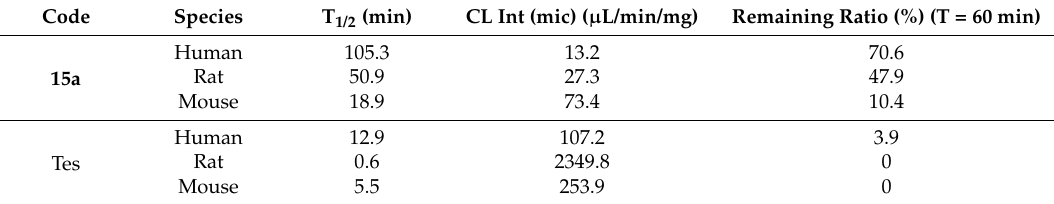
Table 3. Metabolic stability of tested compound in human, rat and mouse liver microsomes a.